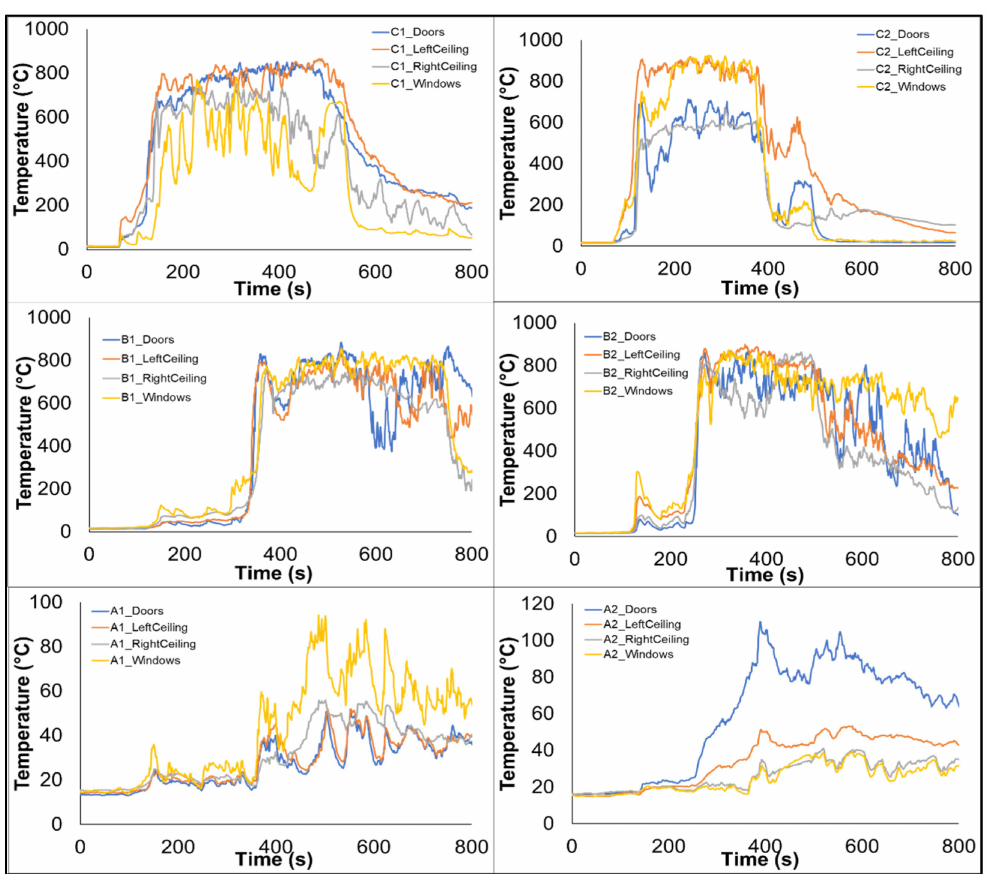
Figure 15. Six RSD experiment: temperature profiles of each RSD in Test